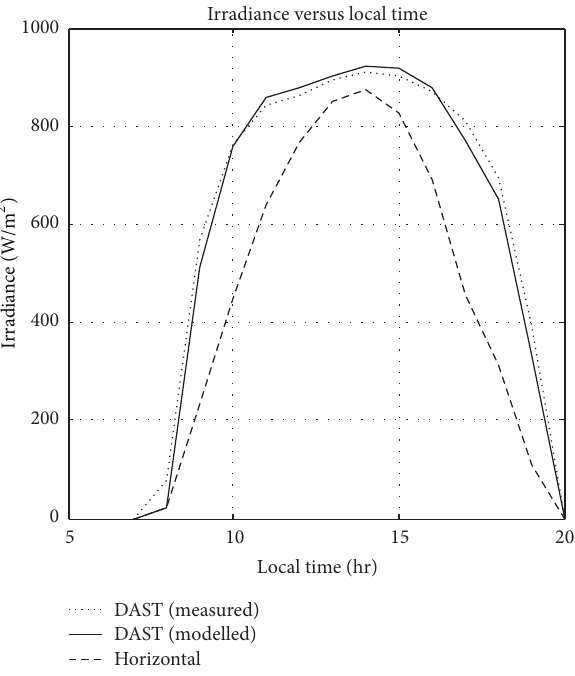
Figure 9: Measured and modeled (anisotropic diffuse model) instantaneous irradiance of DAST and measured irradiance of horizontally positioned SSS.